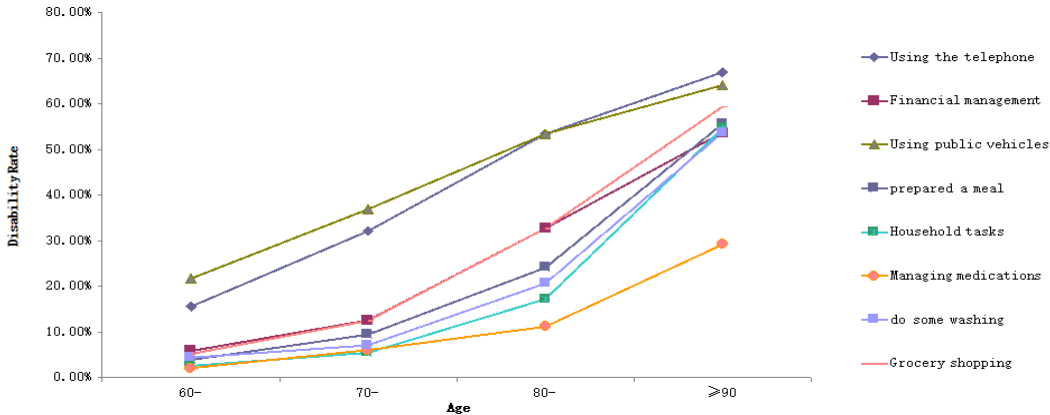
Figure 3. Disability rates of eight items of IADL in the elderly at different ages. Table 2. Trends of disability rates among different age groups in ADL, PADL, IADL, and their items.